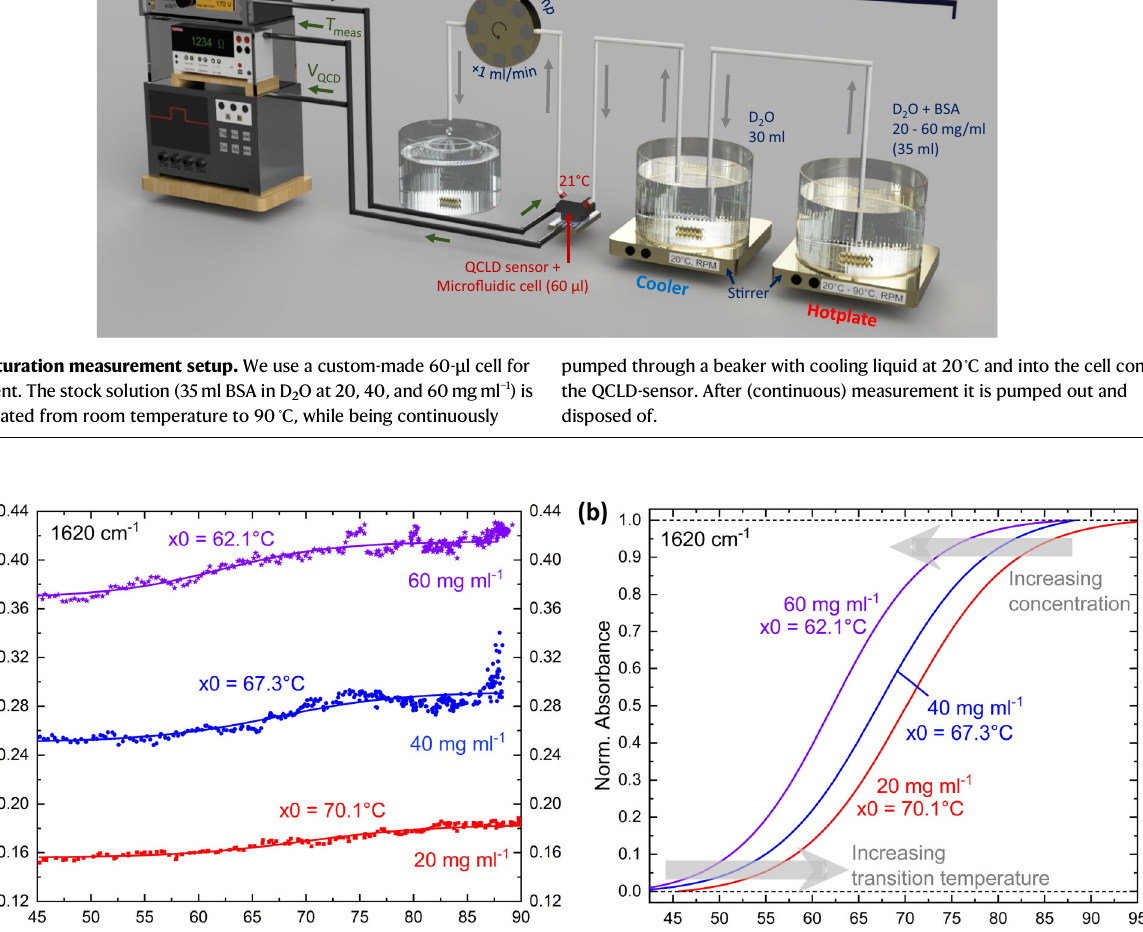
b Comparison of the (individually normalized) Boltzmann- fi t curves, showing the temperature- and concentration-dependence of the sigmoidal-shaped absorbance